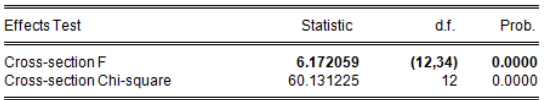
Chow Test Output